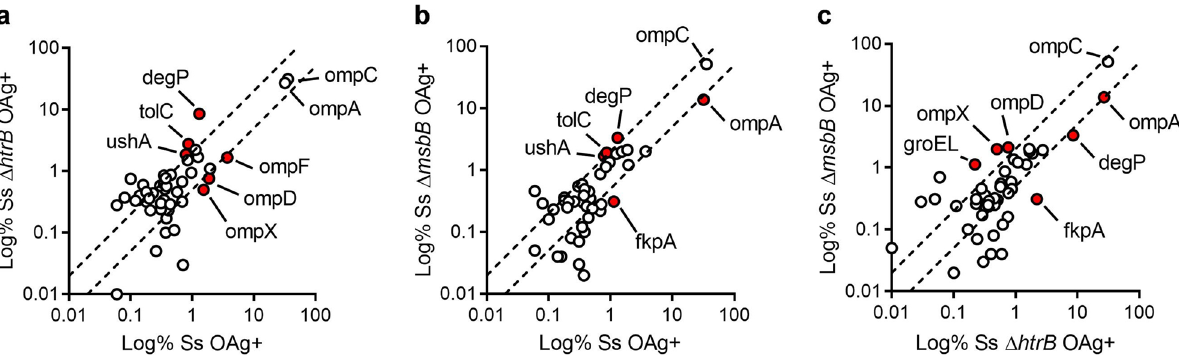
Figure 2. Proteomic analysis of S. sonnei GMMA (most abundant proteins). Proteomic analysis was performed by LC–MS/MS. A global set of 150 proteins were quantified in the six different samples. The abundance of each protein in the OAg-positive GMMA with hexa-acylated lipid A was compared with that of the two OAg-positive GMMA with penta-acylated lipid A ( a , b ). Moreover, the abundance of each protein in the two OAg-positive GMMA with penta-acylated lipid A was compared. Results represent one experiment performed in technical